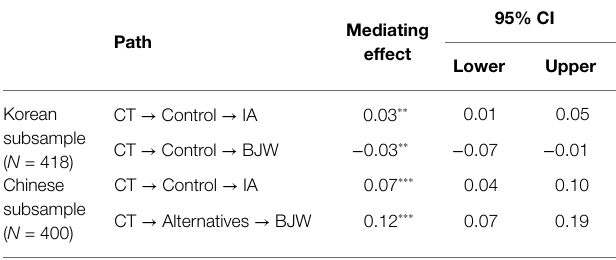
TABLE 4 | Verification results of mediating effect.